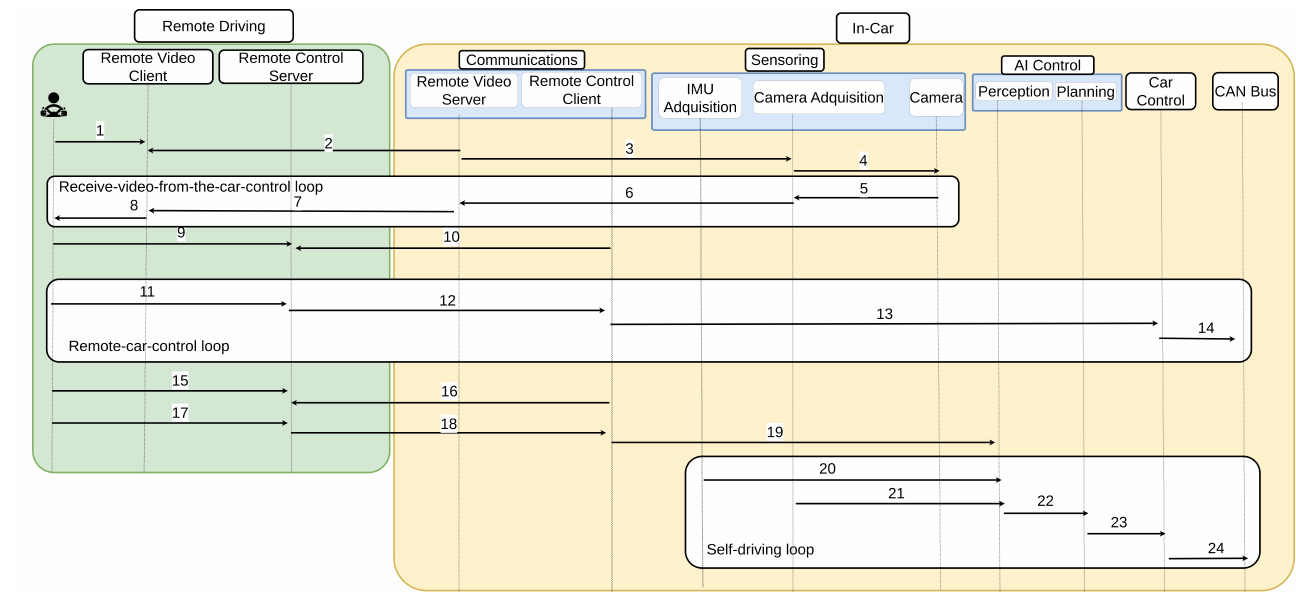
Figure 2. Sequence diagram for remote teledriving. There are three main loops: the receive-video- from-the-car loop; the remote-car-control loop; and the self-driving loop. The steps that compose each loop are: (1) connect to the video client; (2) connect to the video server; (3) and (4) connect to the car’s camera; (5), (6), and (7) send video to the client; (8) display the video on the remote station; (9) connect to the control server; (10) connect to the control client; (11) and (12) joystick commands are sent; (13) the commands are sent to the control module; (14) remote driver’s commands are sent through the CAN bus; (15) and (16) connect with the control server; (17) and (18) control commands are sent; (19) the AI perception daemon is started; (20) IMU lectures are sent to the AI perception module; (21) car motion commands are planned; (22) Plan steering wheel and acceleration commands; (23) planned commands are sent to the control daemon; (24) planned commands are sent through the CAN